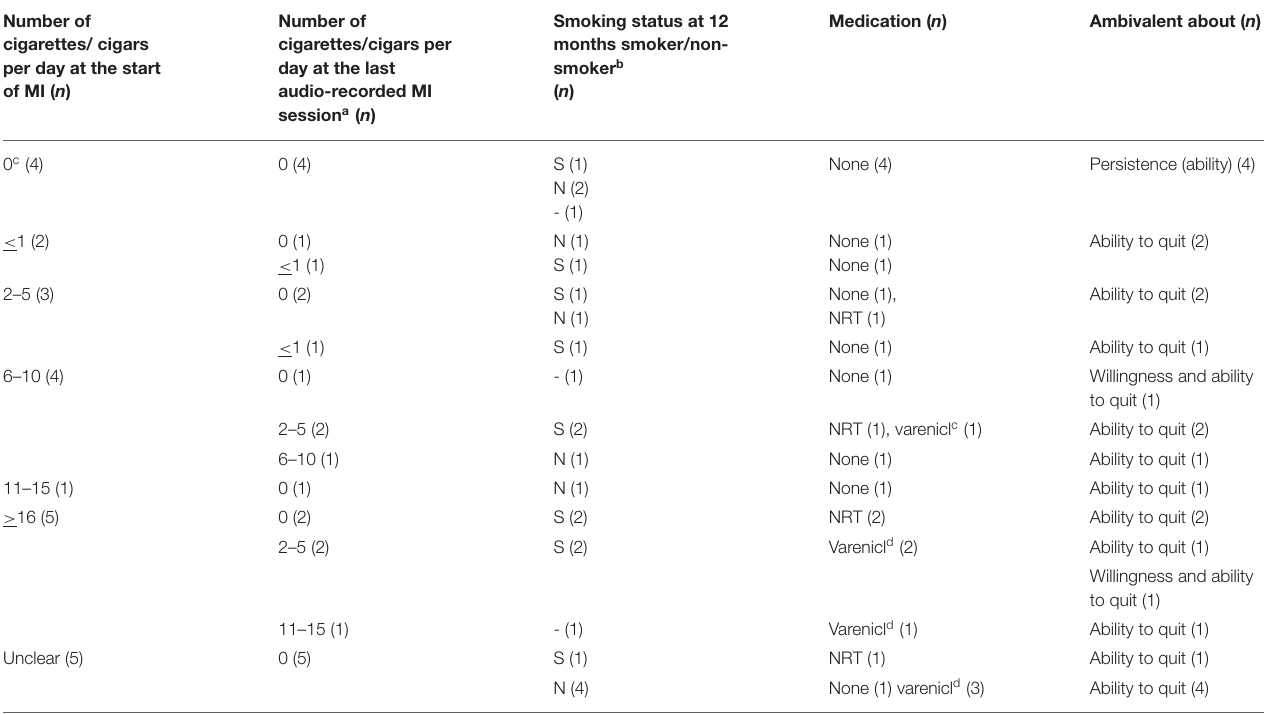
TABLE 5 | Characteristics of smoking behavior and ambivalence. Number of cigarettes/ cigars